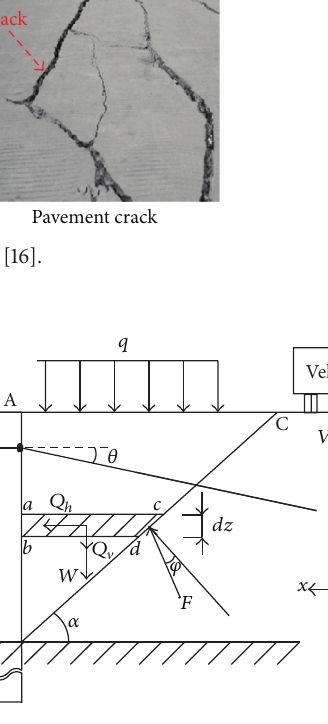
Figure 2: Model for computation earth pressure on piles under vehicle